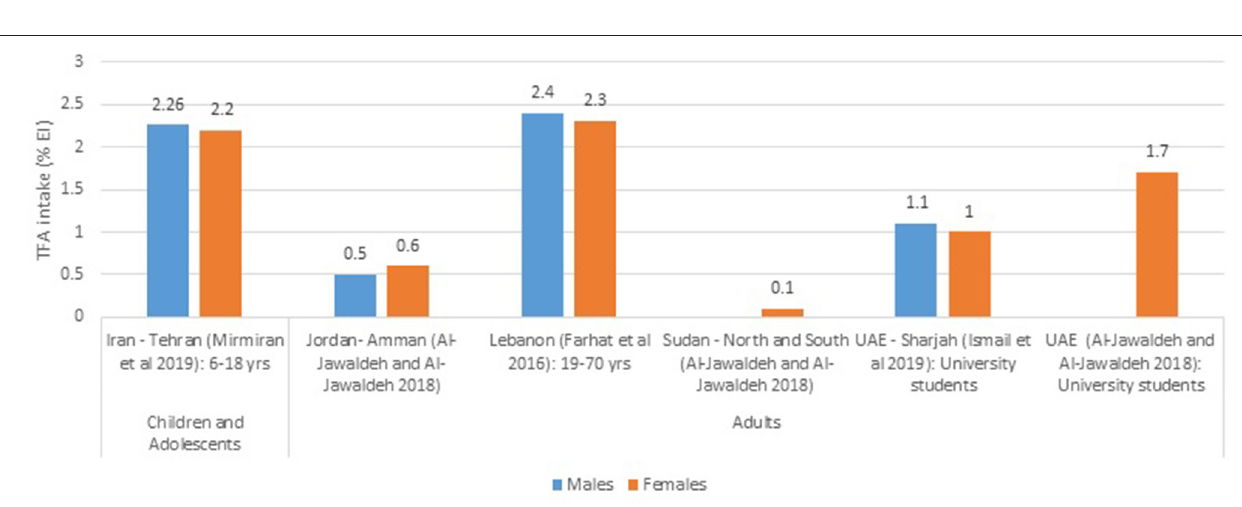
FIGURE 3 | TFA intake estimates (%EI) based on regional studies in countries of the EMR. EI, energy intake; EMR, Eastern Mediterranean Region; MOH, Ministry of health; TFA, trans fatty acids; WHO, World Health Organization. References: For Children and Adolescents: Iran (dietary assessment): Mirmiran et al. (43). For Adults: Jordan and Sudan (dietary assessment): Al-Jawaldeh and Al-Jawaldeh (14); Lebanon (dietary assessment): Farhat et al. (48); UAE (dietary assessment): Ismail et al. (51) and Al-Jawaldeh and Al-Jawaldeh